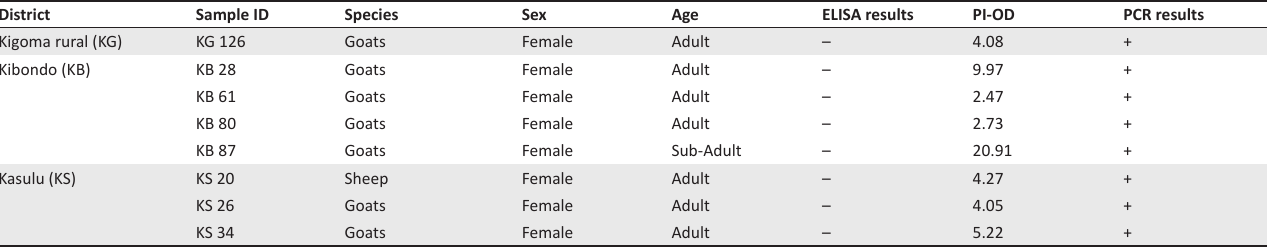
TABLE 3: Serum samples that showed positive results on polymerase chain reaction. District